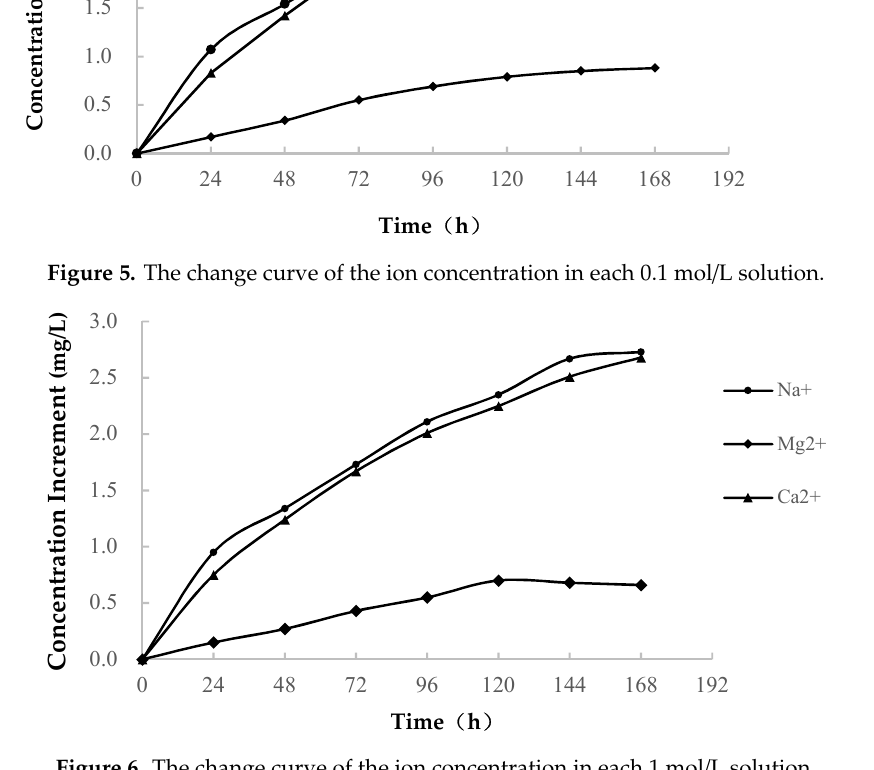
Figure 6. The change curve of the ion concentration in each 1 mol/L solution.